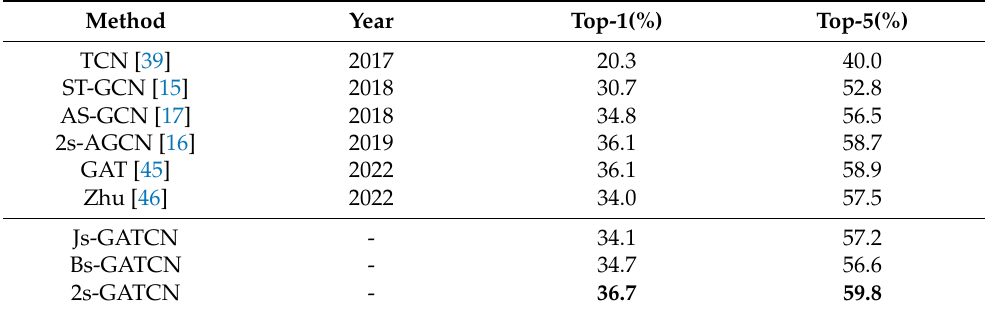
Table 4. Comparisons of the validation accuracy with state-of-the-art methods on Kinetics- Skeleton